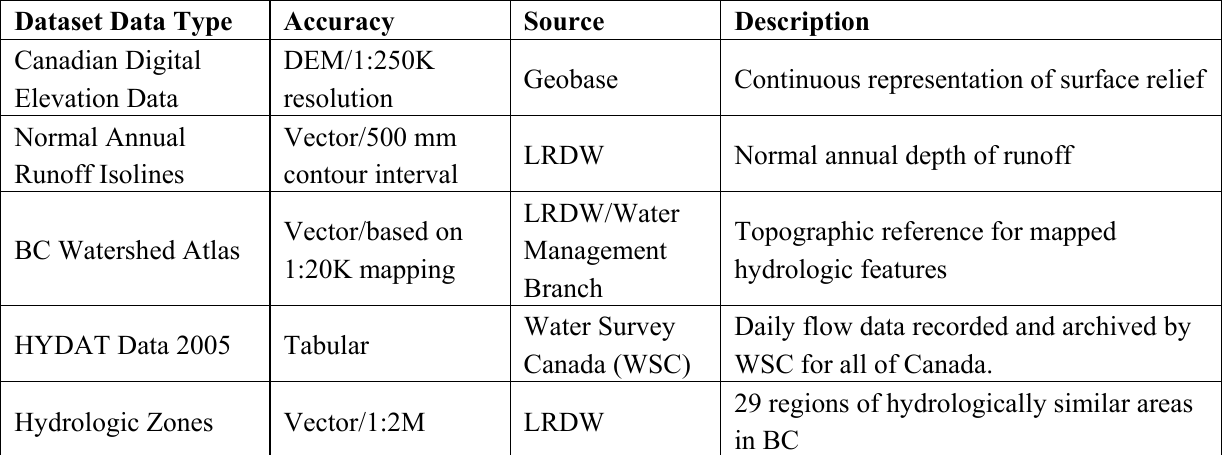
Table 2. Data sources for hydropower assessment